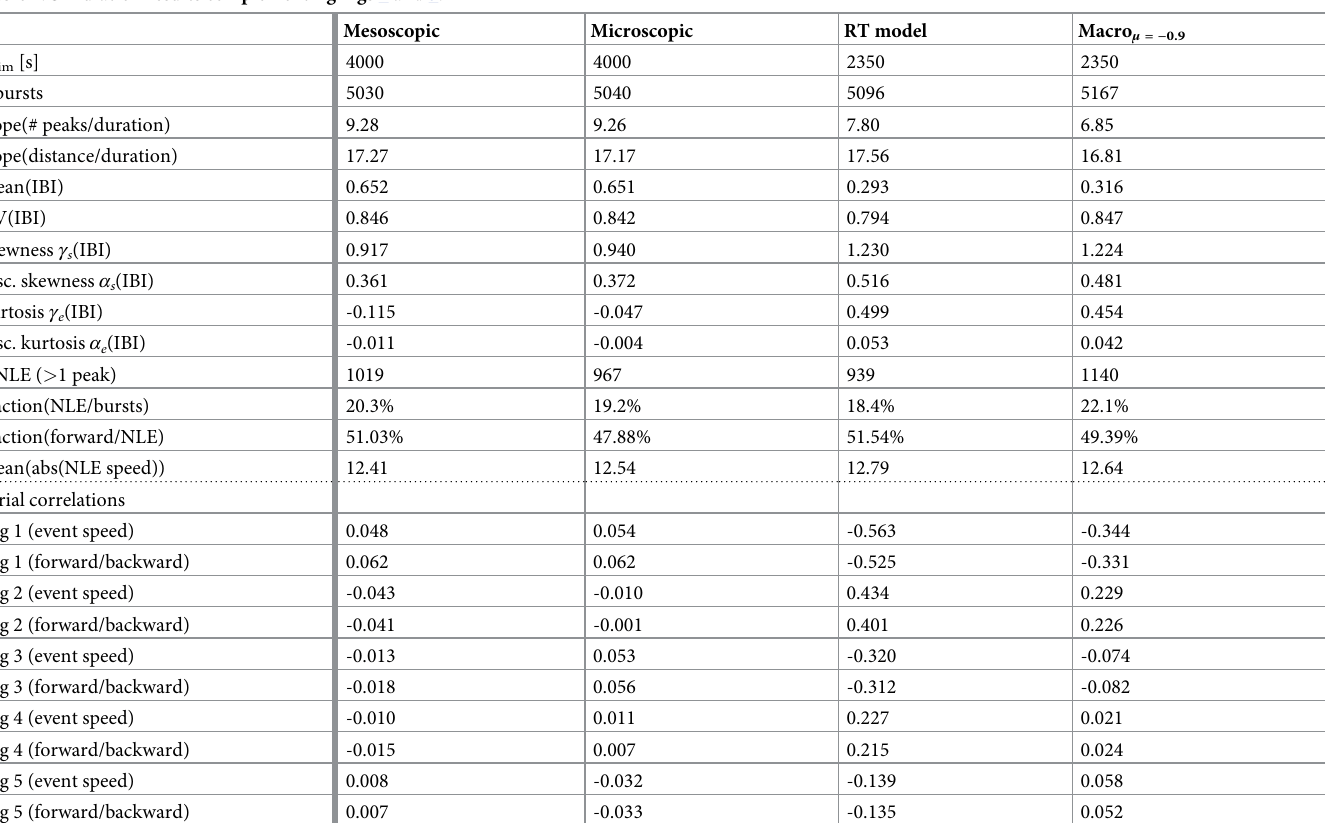
We computed the statistics for the sequence of interburst intervals (IBI) T variation (CV) is CV ¼